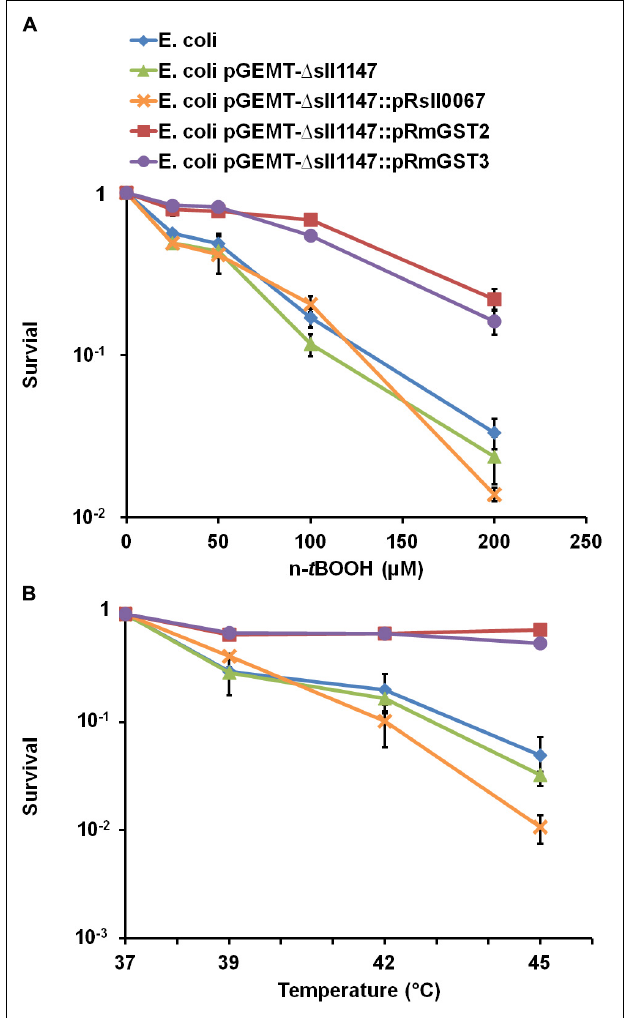
FIGURE 8 | The production of hmGST2 and hmGST3 increase the Escherichia coli survival to n- t BOOH and heat. Survival of E. coli TOP 10 strains harboring, or not (WT control strain) one of the studied GST-producing plasmid challenged for 2 h (initial OD 600 nm = 0.1) by the indicated temperatures (A) or n- t BOOH concentration (B) . Data shown in all panels are expressed as the mean ± SD of three